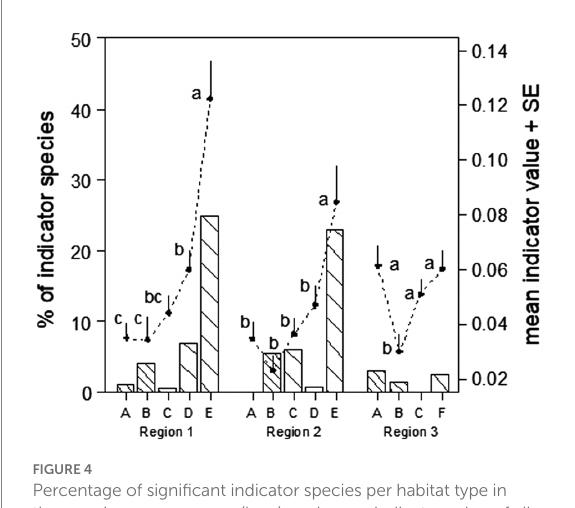
FIGURE 4 Percentage of significant indicator species per habitat type in three regions across years (bars), and mean indicator value of all species (black dots). A: conventional meadow, B: crop field, C: BPA meadow, D: BPA orchard, E: BPA hedge, F: wildflower strip BPA. Points with the same letter are not significantly different (Tukey’s hsd, p <